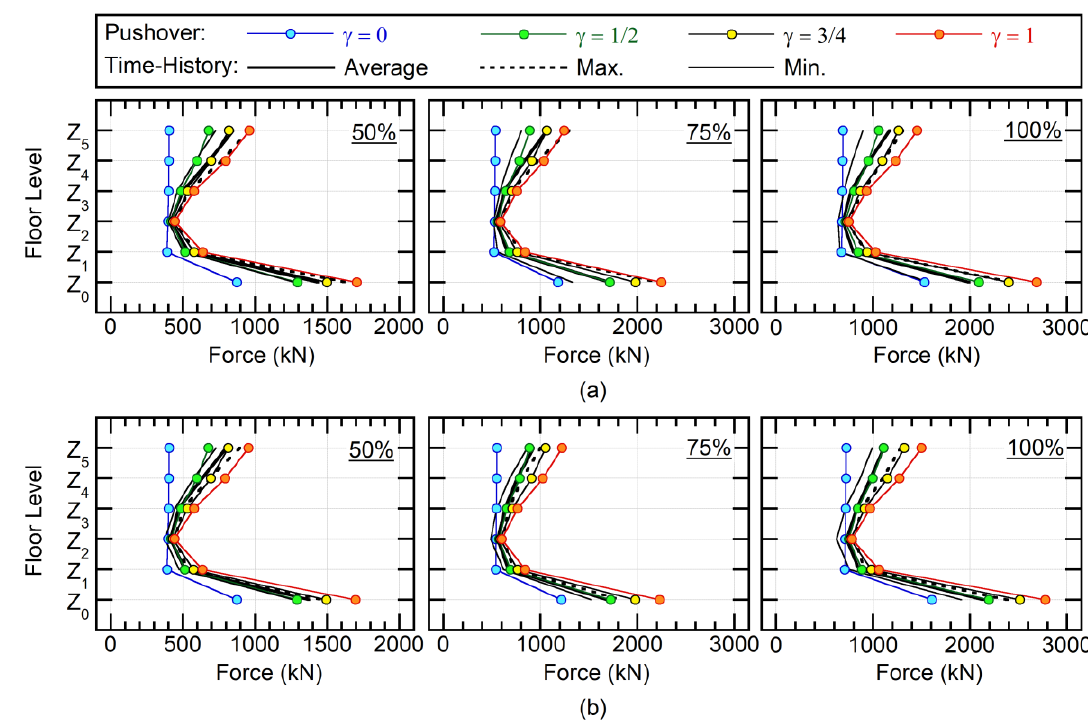
Figure 19. Comparison of the peak restoring force for Model-05: ( a ) Art-S series and ( b ) Art-L series.